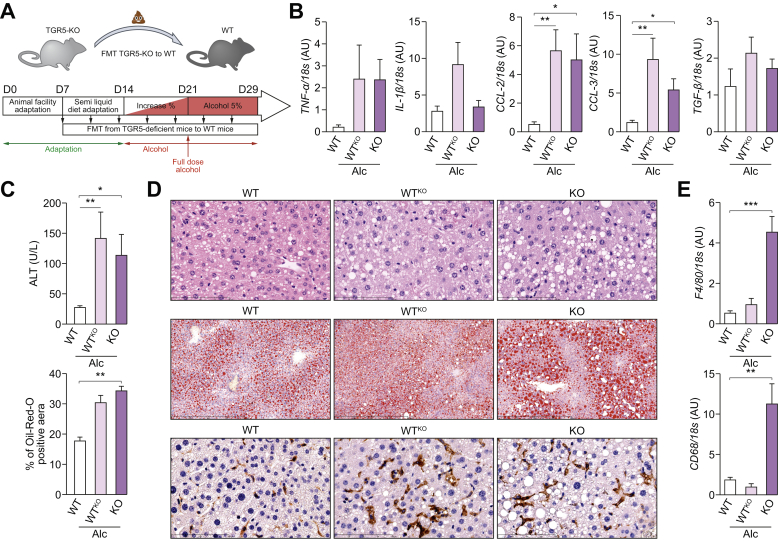
Faecal microbiota transplantation from TGR5-KO to WT mice worsens alcohol-induced liver injury. (A) Experimental design. (B–D) Wild-type (WT), Takeda-G-protein-receptor-5-deficient (TGR5-KO), and WT mice transplanted with the IM of TGR5-KO mice (WTKO) were fed alcohol. (B) Liver mRNA levels of pro-inflammatory cytokines and chemokines. (C) Plasma ALT and quantification of Oil Red O staining. (D) Representative histological images of the liver (upper, scale bar = 100 μm), Oil Red O staining (middle, scale bar = 400 μm), and F4/80 labelling (lower, scale bar = 100 μm). (E) Liver mRNA expression of F4/80 and CD68. Kruskall-Wallis test and Dunn’s multiple comparison post-hoc test, ∗p <0.05, ∗∗p <0.01, ∗∗∗p <0.001. WT n = 5, WTKO n = 5, KO n = 9. IM, intestinal microbiota.